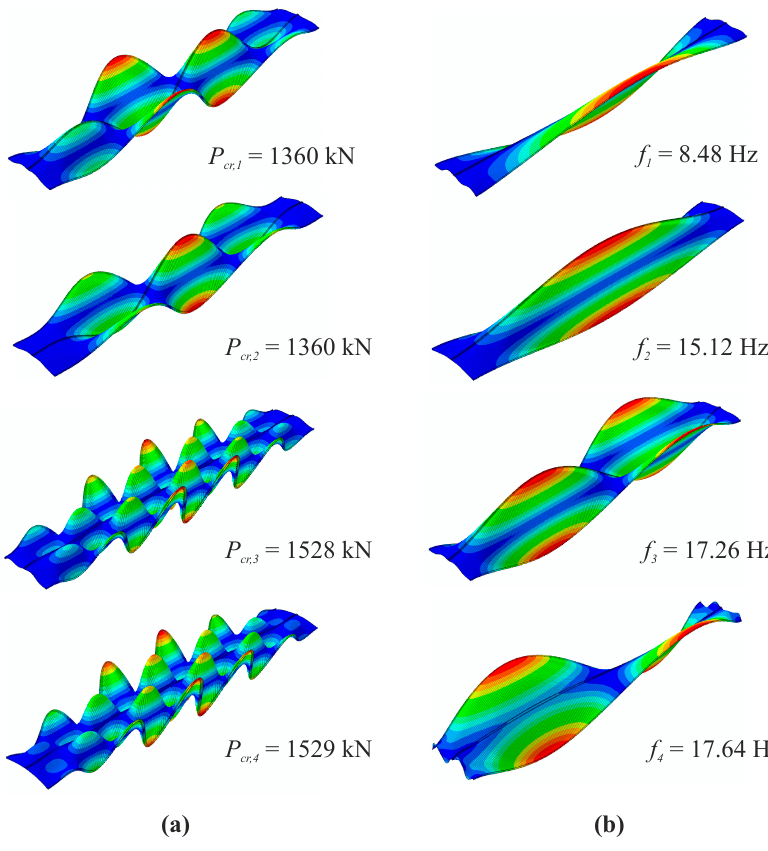
Figure 5. Primary one-to-four modes: ( a ) buckling; ( b ) vibration.